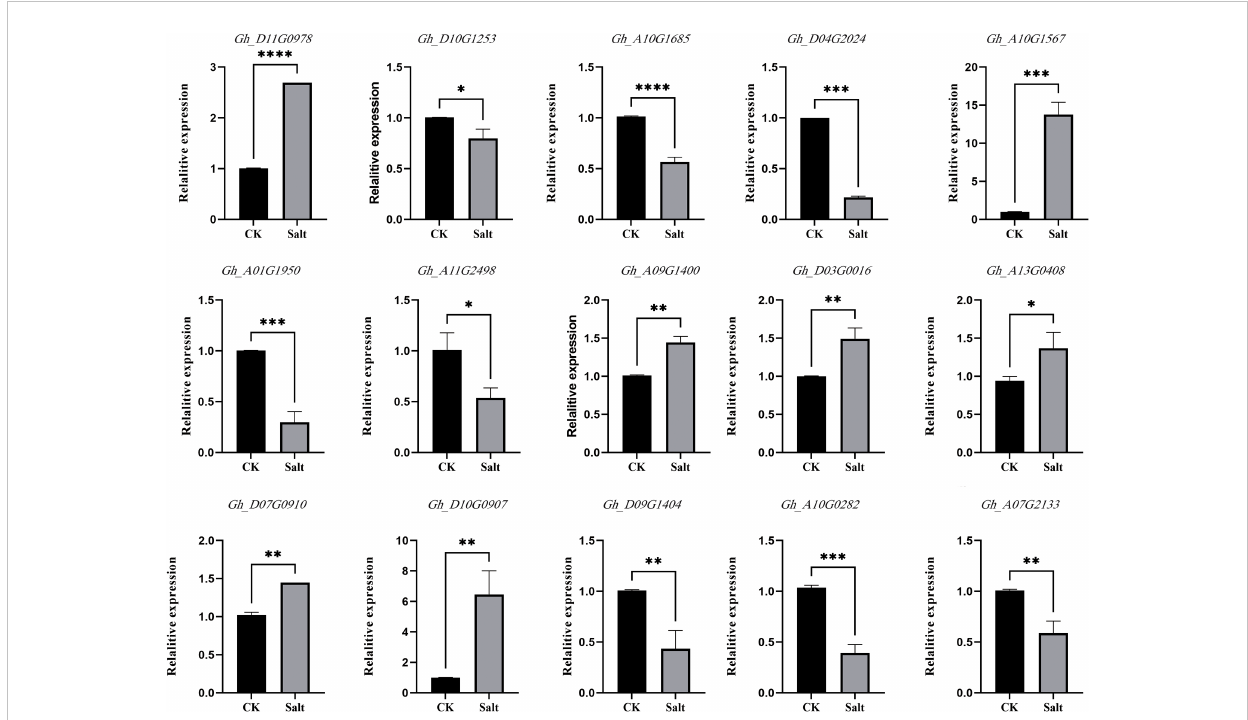
FIGURE 3 Candidate gene expression validation. The abscissa in the fi gure is the sample name, and the ordinate is the relative expression. (** means P ≤ 0.01 in T test, **** means P ≤ 0.0001 in T-test).